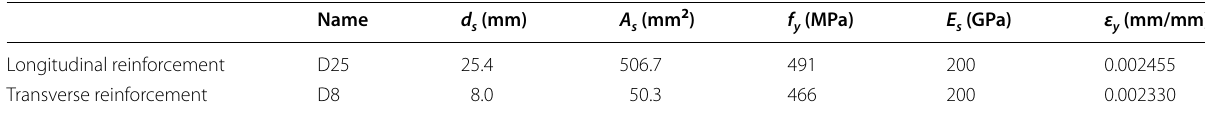
Table 6 Properties of steel reinforcing bars.